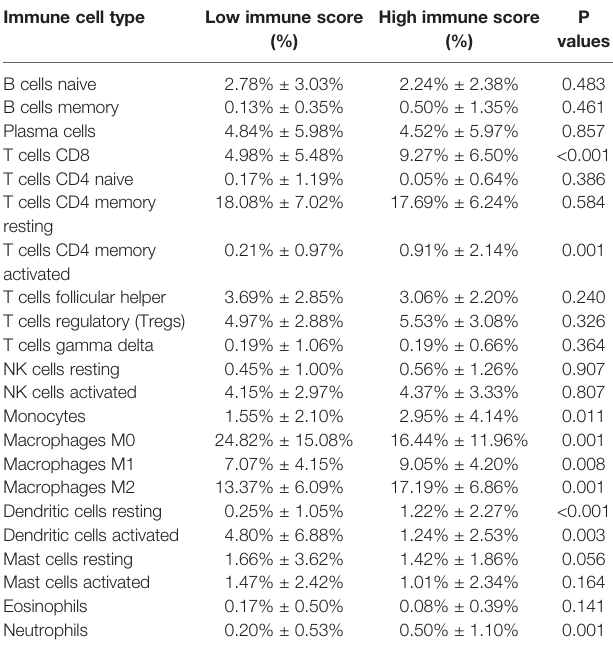
TABLE 1 | Relative proportion of 22 types of immune cells in high and low immune score groups. Immune cell type